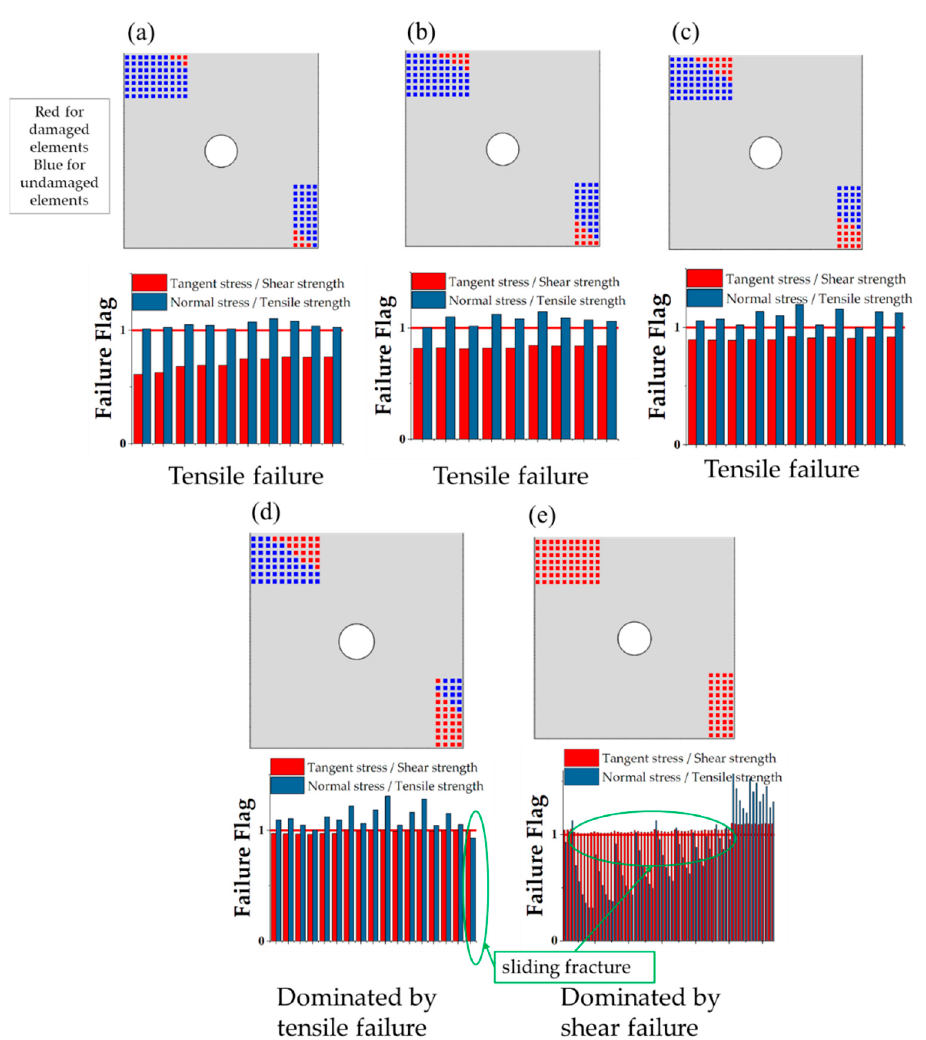
Figure 11. Progressive failure and failure mode of the SiC matrix in deposition zone A (DZA). (Point ( a )–( e ) represent the key moments of the failure process as illustrated in Figure 10.).